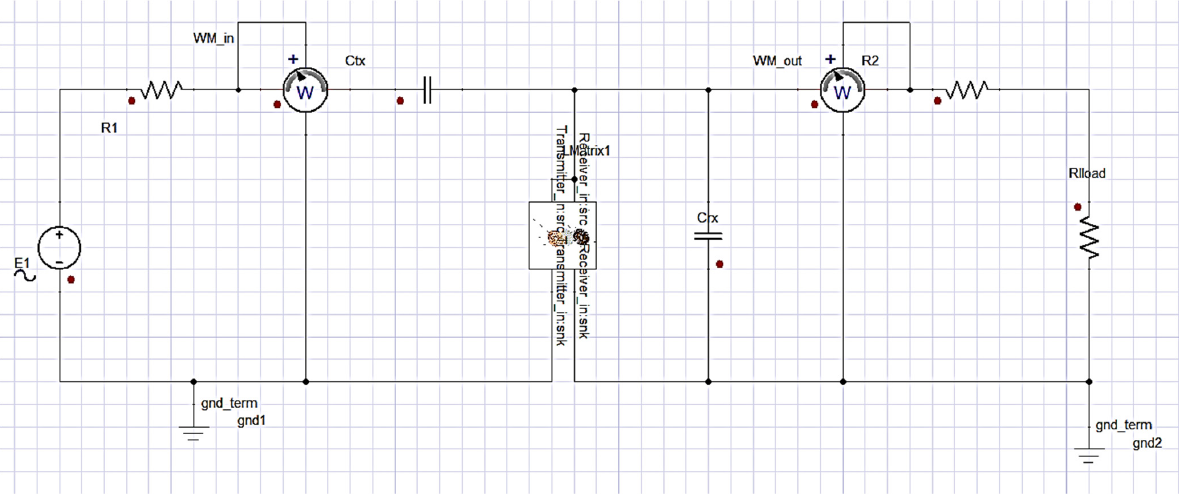
Figure 4. ANSYS Simplorer equivalent